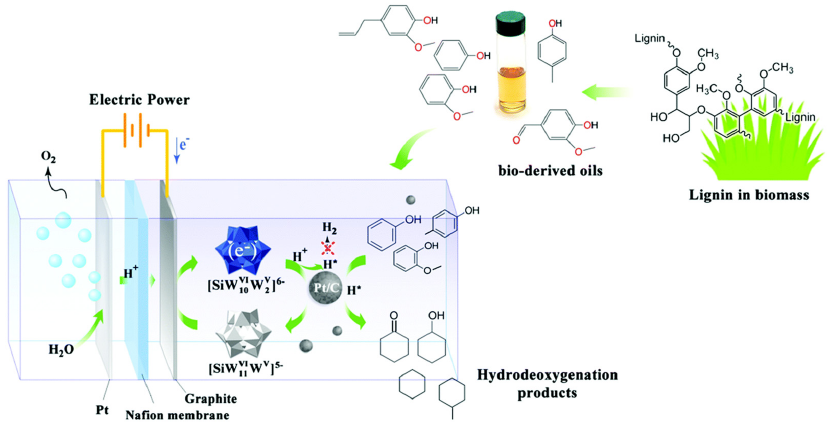
Figure 13. Dual-catalyst slurry system. Reproduced with permission from ref [47]. Copyright 2020 The Royal Society of Chemistry.